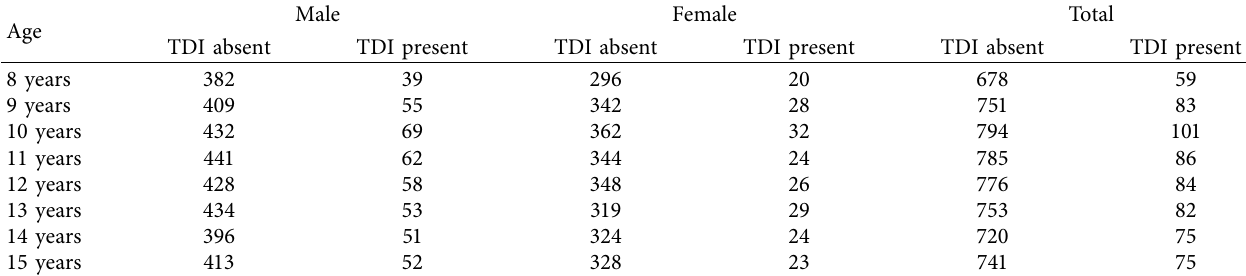
Table 1: Te prevalence of the traumatic injuries according to the age and